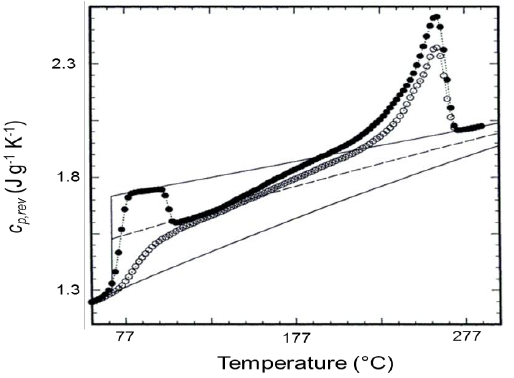
Figure 2. Reversing-specific heat capacity ( c p,rev ) of a melt-quenched amorphous poly(ethylene terephthalate) (PET) sample (filled circles) and a melt-crystallized PET sample (open circles) with crystallinity degree of 44%, measured by quasi-isothermal temperature-modulated differential scanning calorimetry (TMDSC) upon stepwise heating ( p = 60 s and A T = 1.0 K, oscillation time around each temperature: 20 min). The thin solid lines are the solid and liquid specific heat capacities, as taken from [40]. The broken line is the calculated specific heat capacity for a 40% crystalline PET. (Reprinted (adapted) with permission from [5]. Copyright (1997) American Chemical Society).